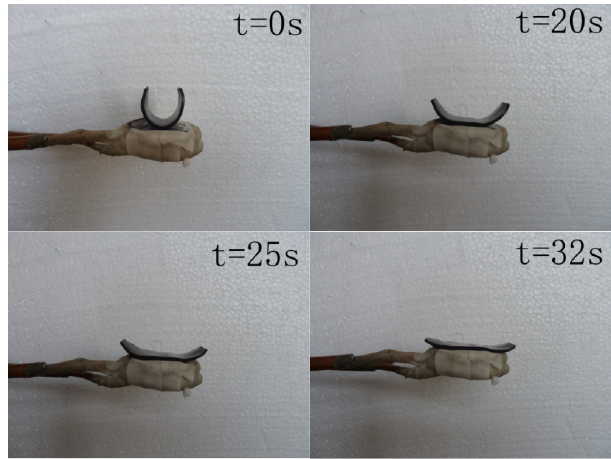
Figure 8. Magnetically induced shape recovery process of SBS/LLDPE composites with 13.5 wt % Fe 3 O 4 in an alternating field ( f = 60 kHz, H = 21.21 kA ∙ m − 1 ).